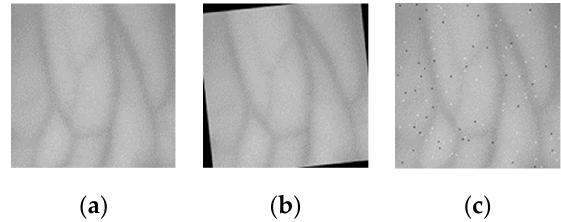
Figure 2. Acutance evaluations on an 850 nm dorsal hand vein region of interest (ROI) image using different methods. ( a ) Original ROI with Tenengrad = 6.992, edge acutance value (EAV) = 12.214, and thresholded pixel-wise acutance value (TPAV) = 15.226; ( b ) Rotated ROI with Tenengrad = 9.816 ( + 40.4 %), EAV = 13.853 ( + 13.4%), and TPAV = 14.140 ( − 7.1%); ( c ) Noisy ROI with Tenengrad = 7.549 ( + 7.9%), EAV = 23.265 ( + 90.5 %), and TPAV = 16.685 ( + 9.6%).